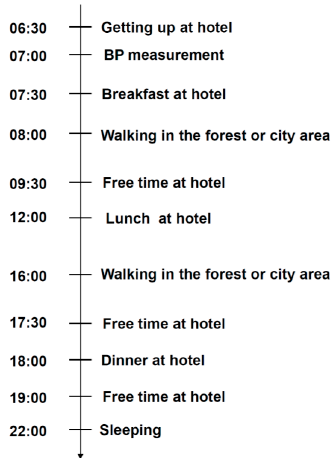
Figure 2. The experimental protocol for subjects exposed to the forest or city environment.